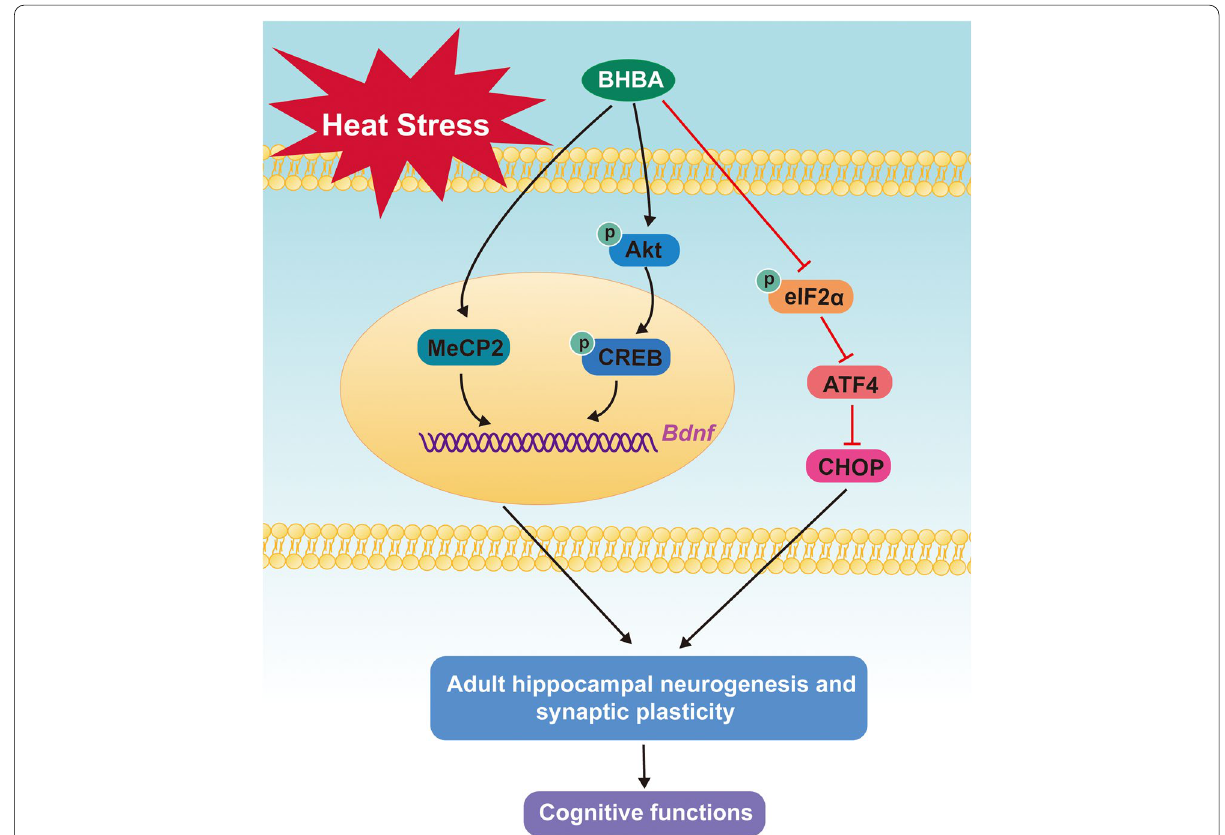
Fig. 8 Schematic illustration of the possible protective mechanisms of BHBA administration in heat stress-induced cognitive dysfunctions in